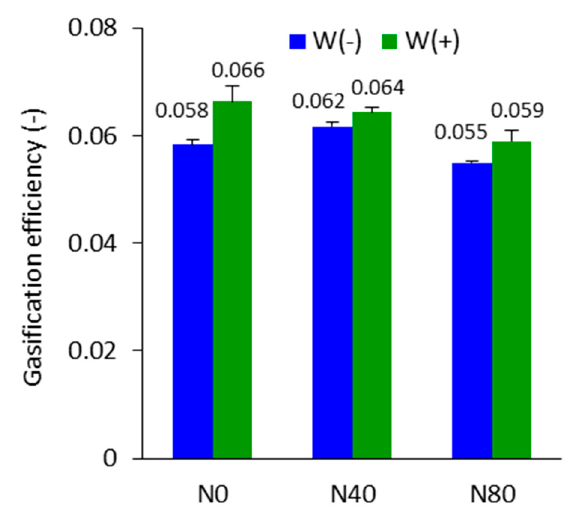
Figure 8. Gasification efficiency.